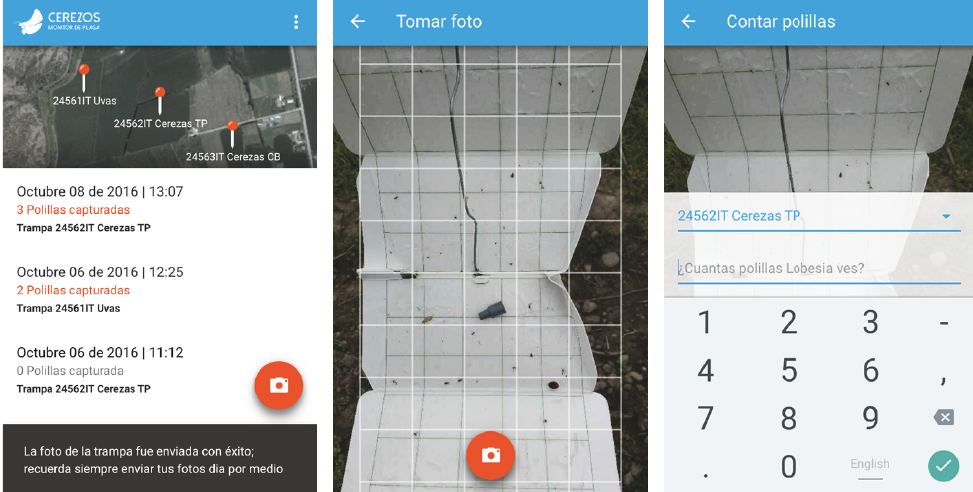
Figure 1: Mobile application.